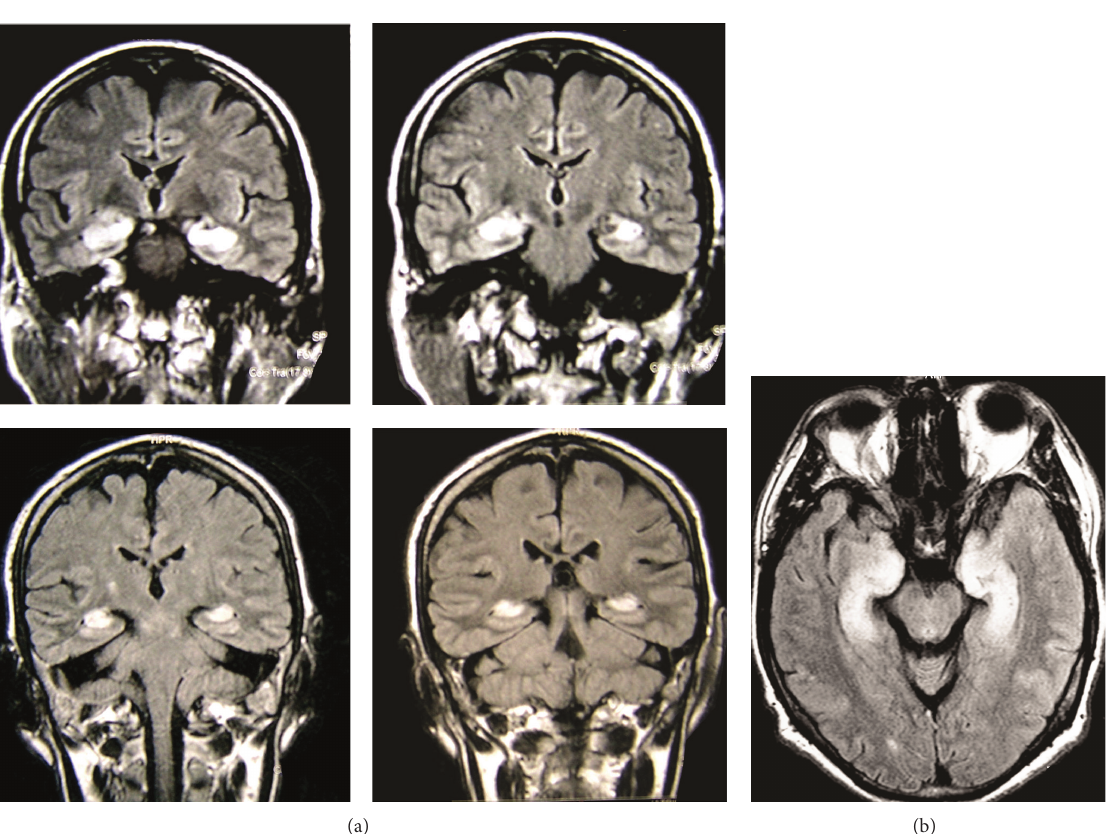
Figure 1: (a) Coronal FLAIR brain MR images demonstrate hyperintense lesions in medial temporal lobes bilaterally. (b) Axial FLAIR brain MR image demonstrates hyperintense lesions in medial temporal lobes